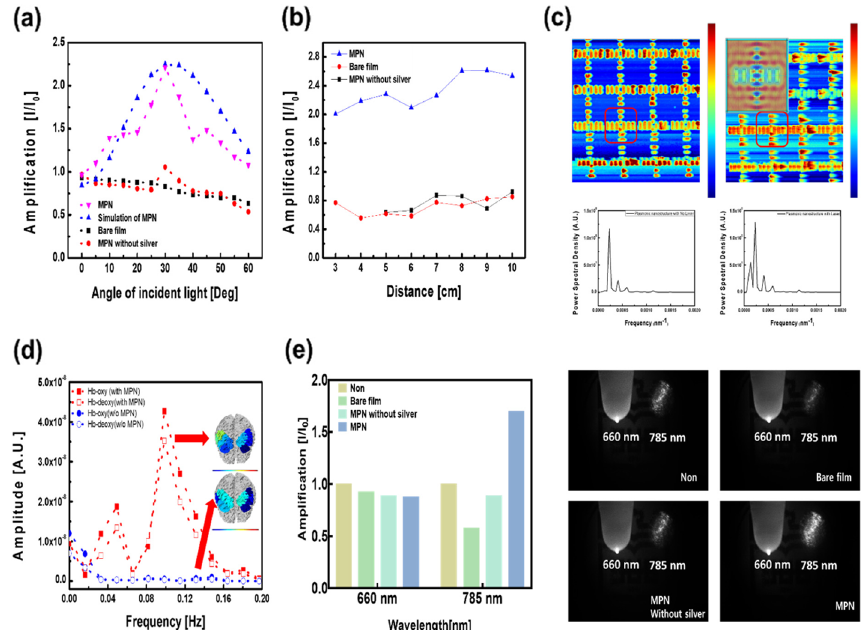
Fig. 5 Graph showing the dependence of the amplified optical signal on the distance, angle of incident light, and application. a shows that the plasmonic nanostructure amplifies the optical intensity when the plasmonic and incident light wave vectors are matched. When the angle of incident light is 30°, the plasmonic and incident light wave vectors are matched. b shows the amplification depending on the distance, demonstrating that the plasmonic nanostructure was more affected when the optical intensity was weak. c shows AFM data which without the laser(left) and with laser(right). d shows the